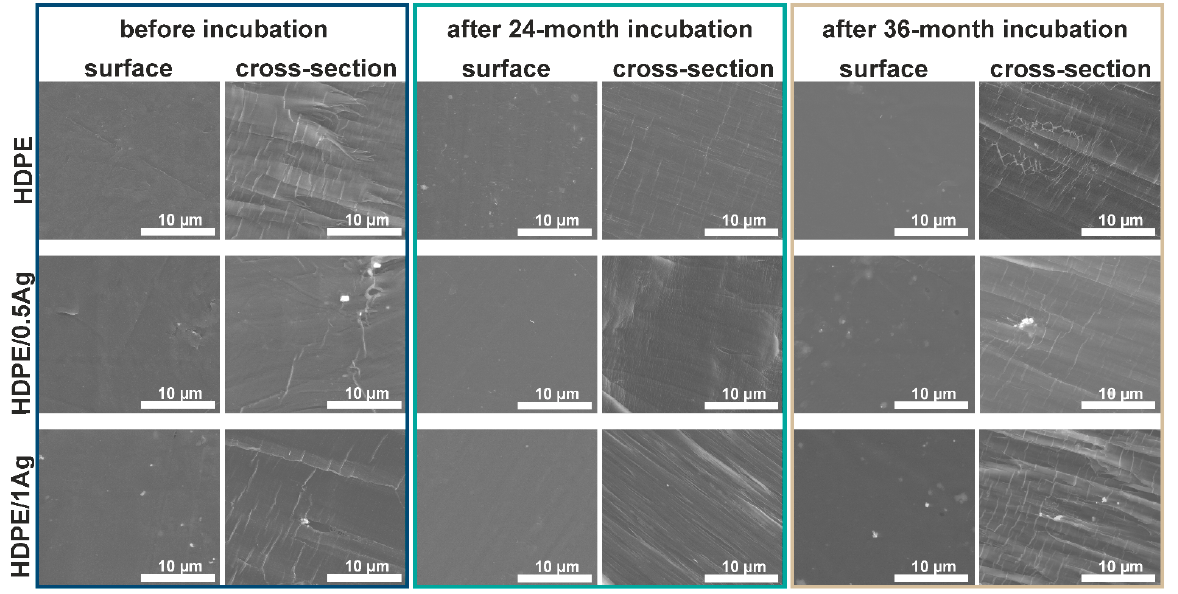
Figure 3. SEM images of surface and cross-section of high-density polyethylene (HDPE) and HDPE-based composites modified with 0.5 wt.% and 1.0 wt.% AgNPs before and after the 24- and 36-month incubation periods in deionized water.